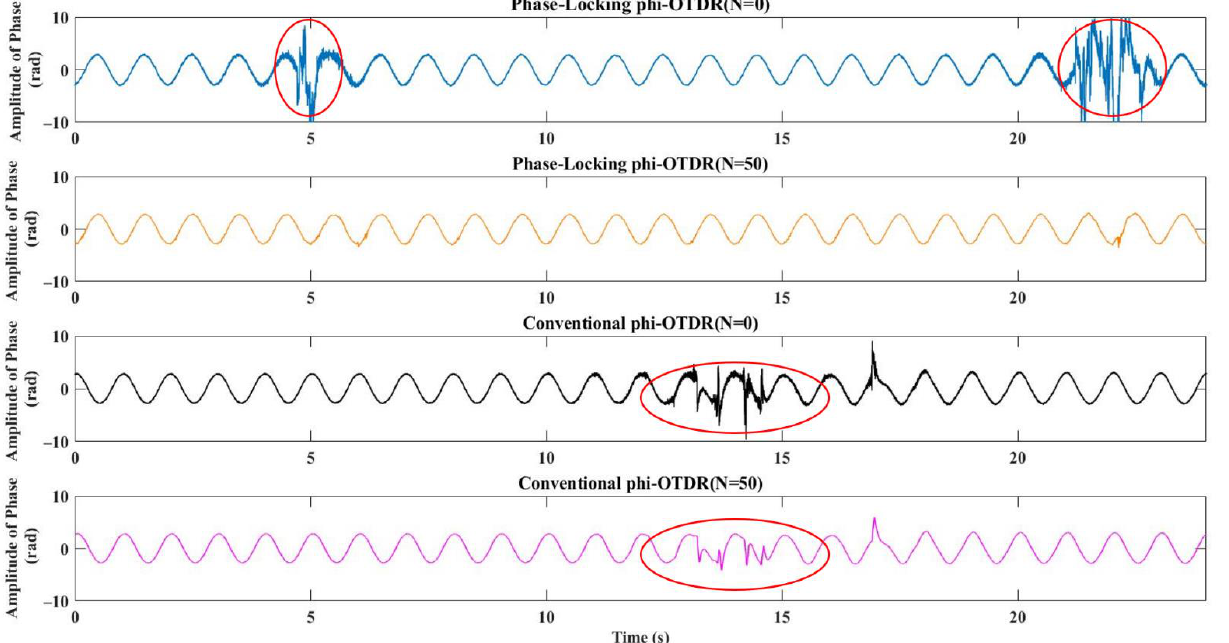
Figure 8. Waveforms of the reconstructed vibration signals from the conventional and phase-locking ϕ -OTDR with different N.